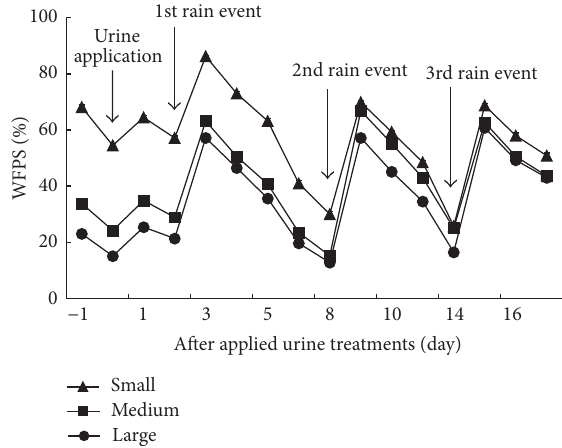
Figure 1: Changes in water-filled pore space (WFPS %) during the experiment. Triangles, squares, and circles are small, medium, and large aggregates, respectively. The errors were standard deviations ( 𝑛 = 3 ). The arrows express the timings for urine application and three simulated heavy